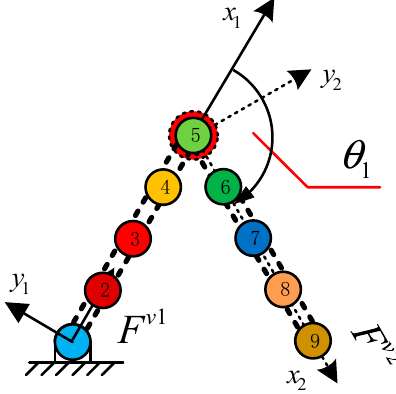
Figure 6. Predefined virtual linkage used in these two simulations.